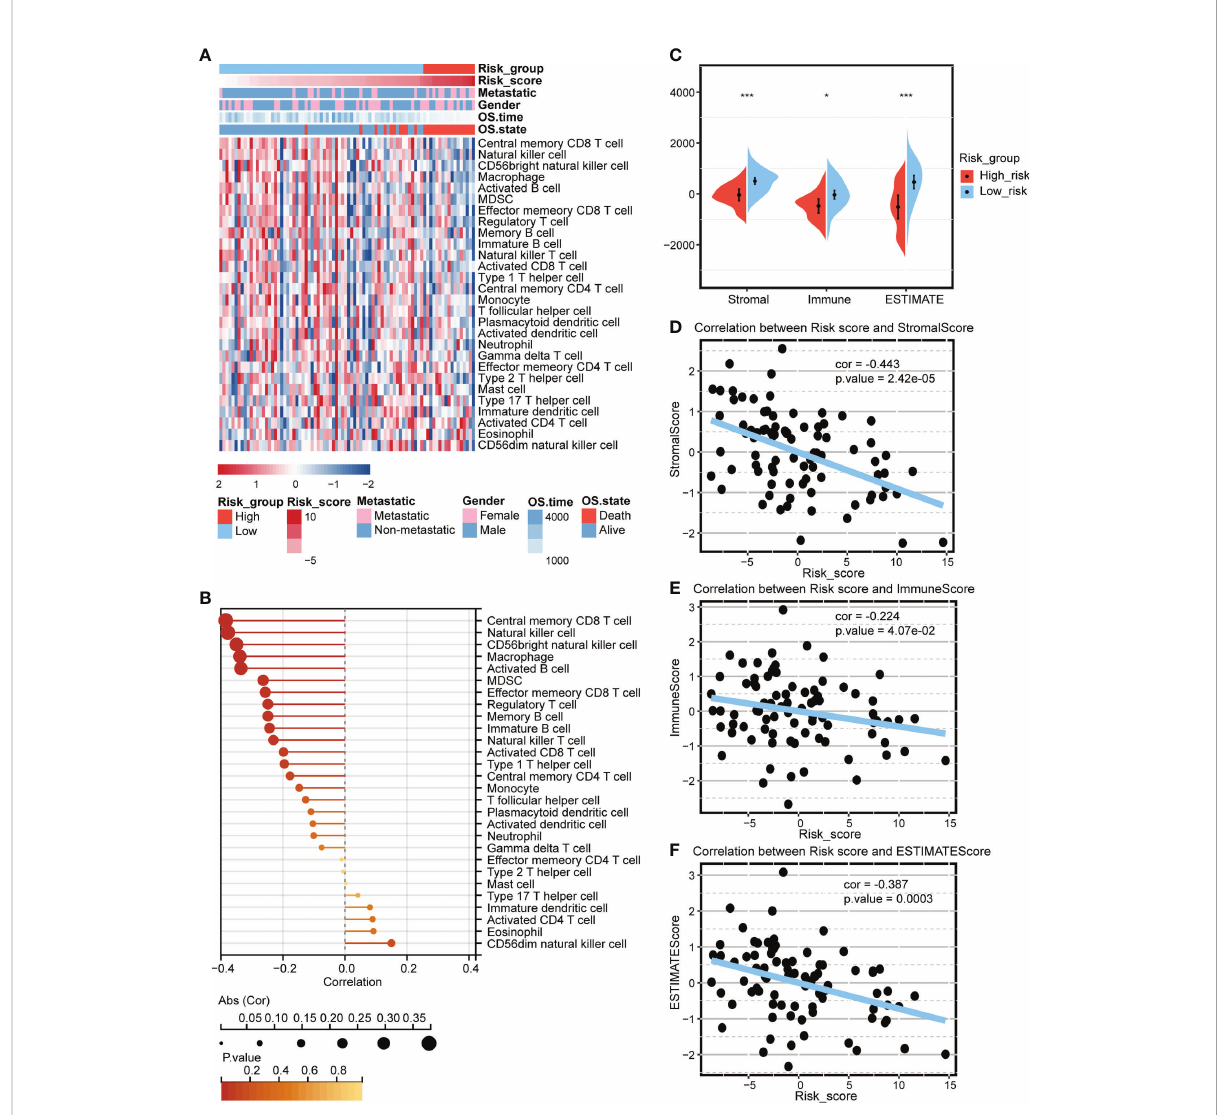
FIGURE 3 Predictive value of the mitochondria-related signature in the immune microenvironment. (A) Heatmap depicting the association between the mitochondria-related signature and immune cells. (B) Dot plot depicting the association between the mitochondria-related signature and immune cells. (C) The different levels of the mitochondria-related signature score regarding microenvironment scores. (D) The association between the mitochondria-related signature and stromal score. (E) The association between the mitochondria-related signature and immune score. (F) The association between the mitochondria-related signature and ESTIMATE score. *p < 0.05; ***p <